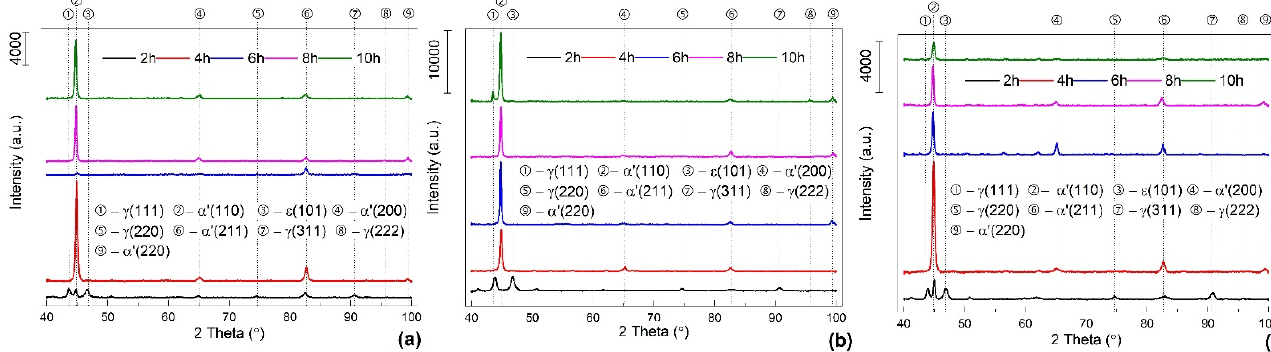
Figure 7. Typical XRD pa tt erns of solution-treated specimens after the application of DMA-SS-3PB with di ff erent frequencies: ( a ) 1 Hz; ( b ) 5 Hz; and ( c ) 10 Hz.